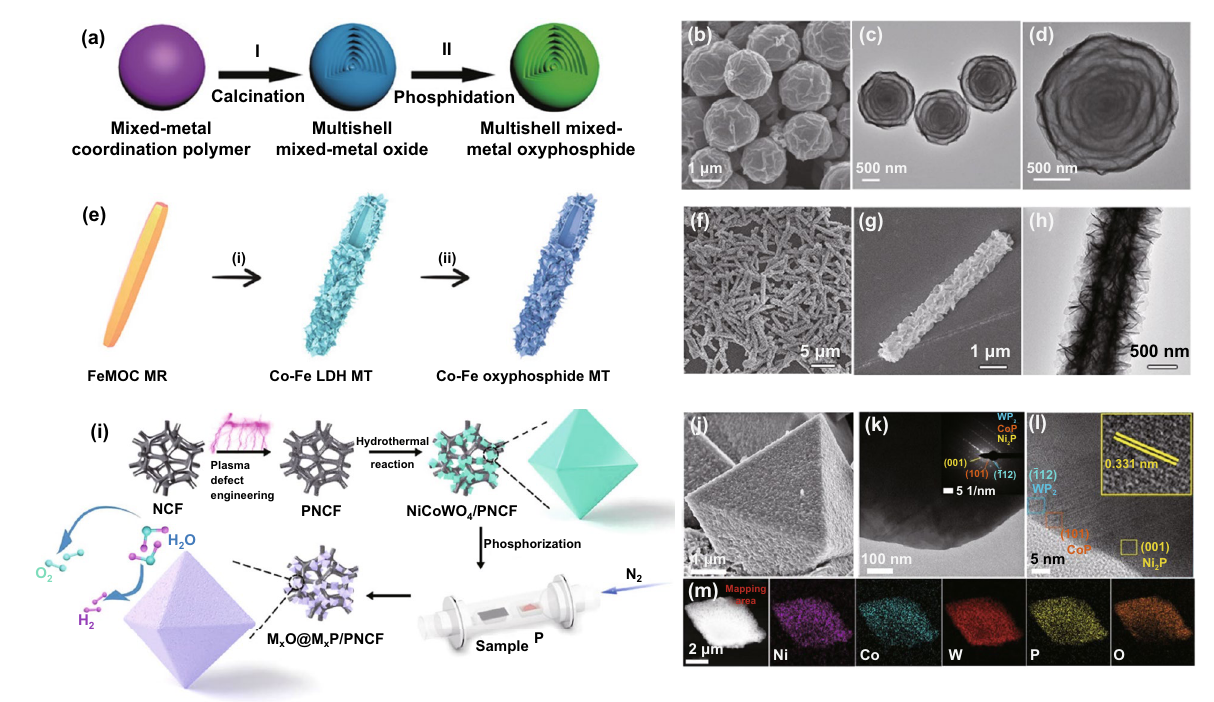
Fig. 7 a Formation of multishell mixed-metal oxyphosphide particle, b FESEM and c, d TEM images of the multishell Mn–Co oxyphosphide particles. Reprinted with permission from Ref. [118]. Copyright Year 2017, Wiley–VCH Verlag GmbH & Co. KGaA, Weinheim. e Schematic illustration of the formation process of hierarchical Co–Fe oxyphosphide MTs, f, g FESEM and h TEM images of hierarchical Co–Fe LDH MTs. Reprinted with permission from Ref. [119]. Copyright Year 2019, Wiley–VCH Verlag GmbH & Co. KGaA, Weinheim. i Fabrication of a multiphase, trimetallic Ni–Co–W phosphoxide electrocatalyst: Regular octahedral multiphase M x O@M x P crystals are formed in situ on plasma- defect-engineered Ni–Co support, j high-resolution SEM image, k, l low-and high-resolution TEM images, the inset in k is the SAED pattern of the M x O@M x P/PNCF particle, and m HAADF-STEM image and EDX elemental mapping of a single M x O@M x P/PNCF. Reprinted with per- mission from Ref. [120]. Copyright Year 2021, American Chemical